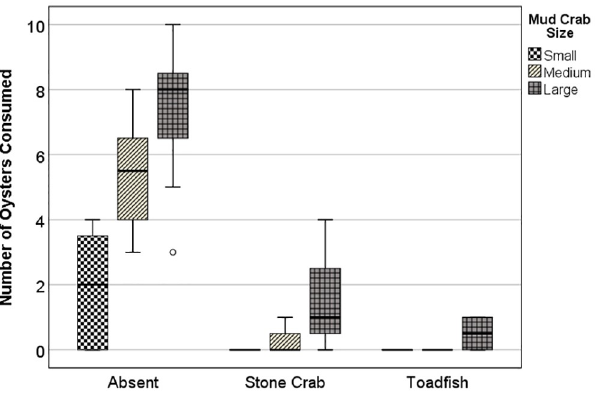
Fig 2. TMII experiment. Consumption of juvenile oysters by three size classes of mud crabs across three caged predator treatments, absent, stone crab, and toadfish.